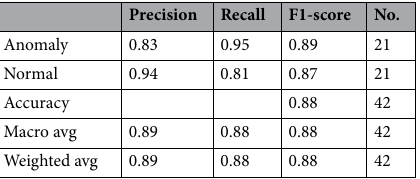
Precision Recall F1-score No.